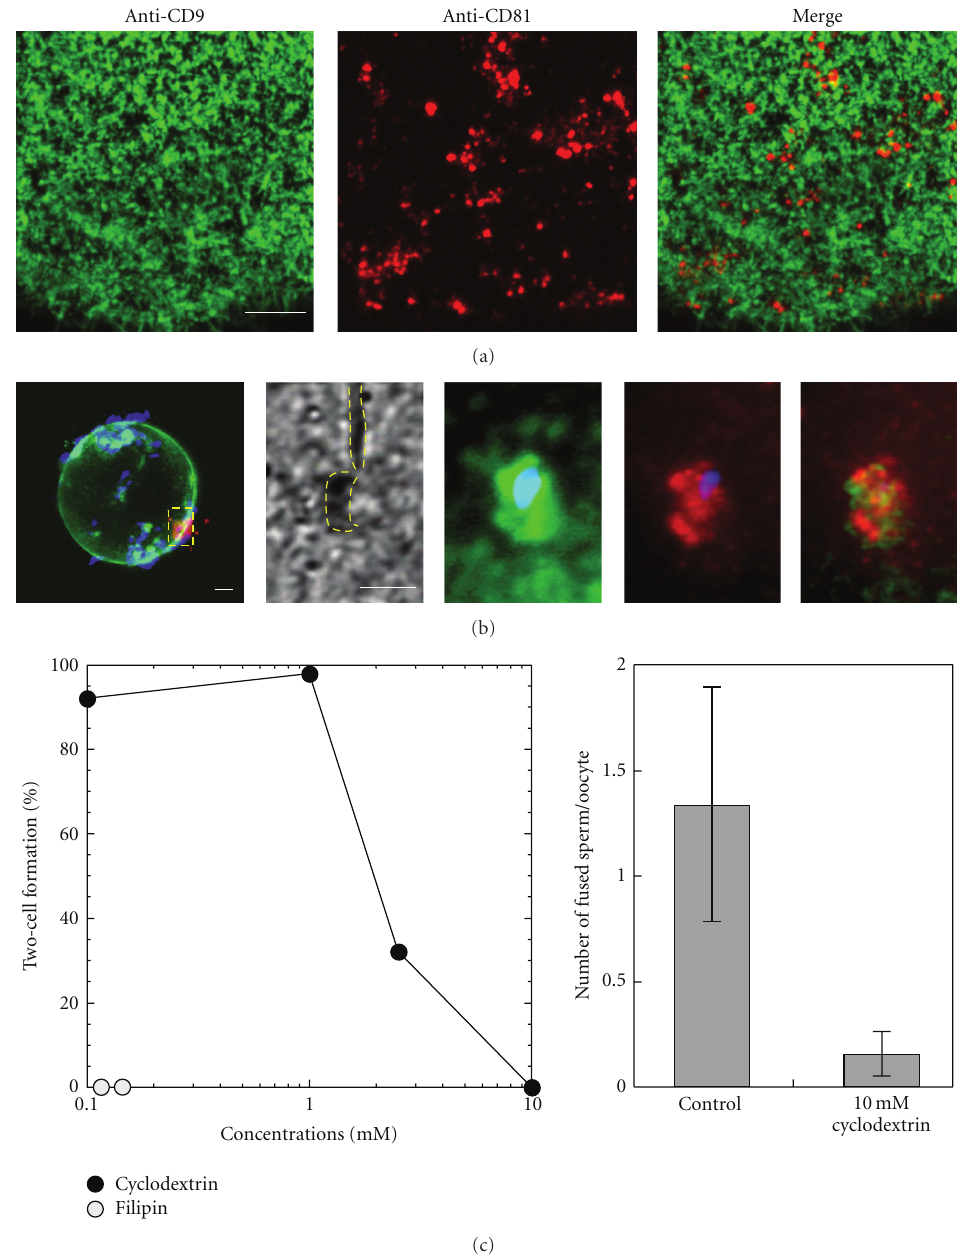
Figure 3: Distribution and function of CD9 and CD81 in murine oocyte. (a) The distribution of CD9 (green) is distinct from that of CD81 (red). CD9 localizes over the entire surface membrane, except for the MII plate, whereas CD81 shows patches with a low frequency. Scale bar = 10 μ m. (b) Cell surface-bound sperm shows colocalization of CD9 and CD81 with sperm nuclei (blue). Scale bar = 10 μ m. (c) Pretreatment of an oocyte with cyclodextrin (CD) prevents sperm from fusing and fertilizing the oocyte. The same phenomenon is observed in the treatment of